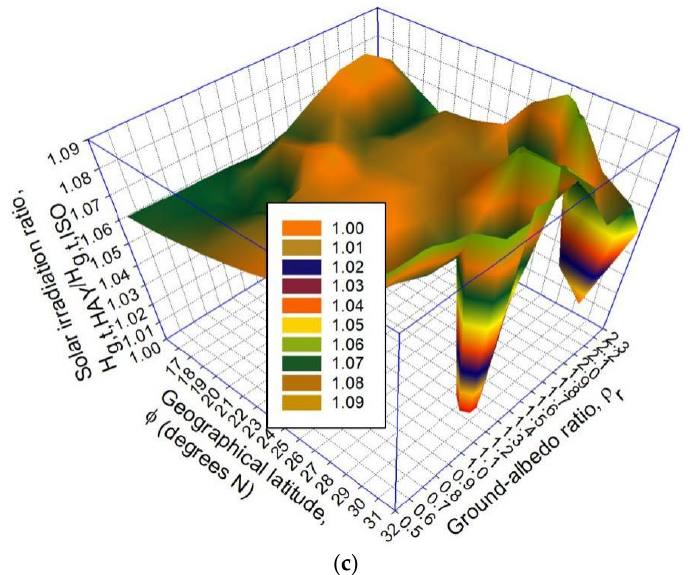
Figure 9. 3D plots of the ratio H g,HAY /H g,ISO as functions of the geographical latitude, φ , and the ground–albedo ratio, ρ r , for Saudi Arabia under all-sky conditions. The solar irradiation ratios are averages of the annual mean solar irradiations, H g,HAY and H g,ISO , at each of the 82 sites and the period 2005–2016. The solar irradiation ratios cover system configuration ( a ) mode (i), ( b ) mode (ii), and ( c ) mode (iii). The (x,y,z) triads in the graphs refer to the parameters ( φ , ρ r , H g,HAY /H g,ISO ), respectively.